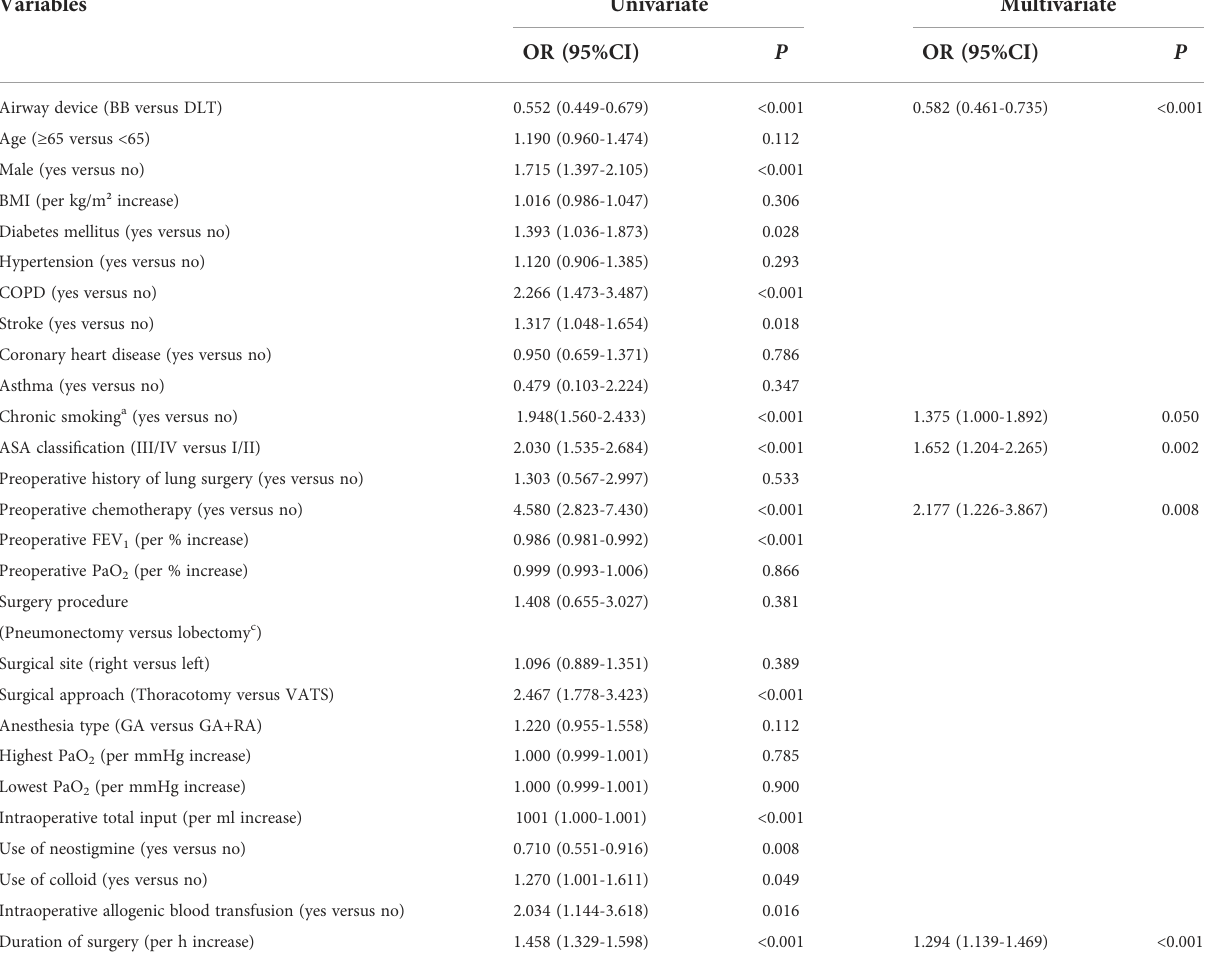
TABLE 4 Univariate and multivariate analysis of factors independently associated with PPCs.